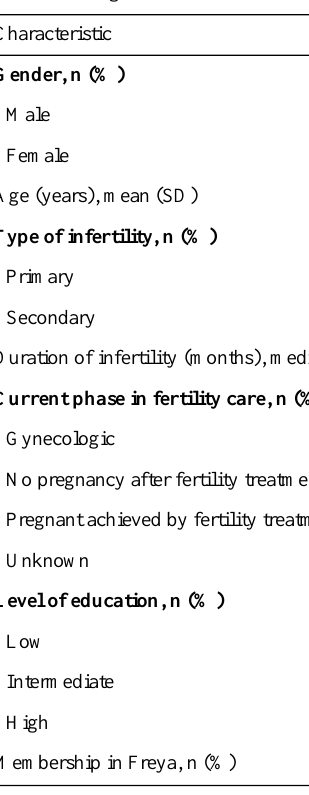
Table 2. Background characteristics of respondents (n = 45) to the evaluation questionnaire.